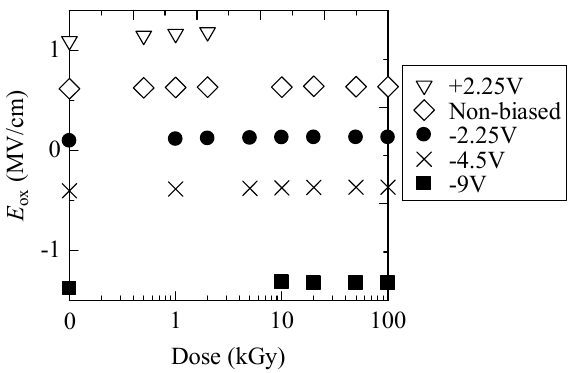
Figure 3. Plots of electric field gradient in the oxide during irradiation ( E ox ) as a function of dose.